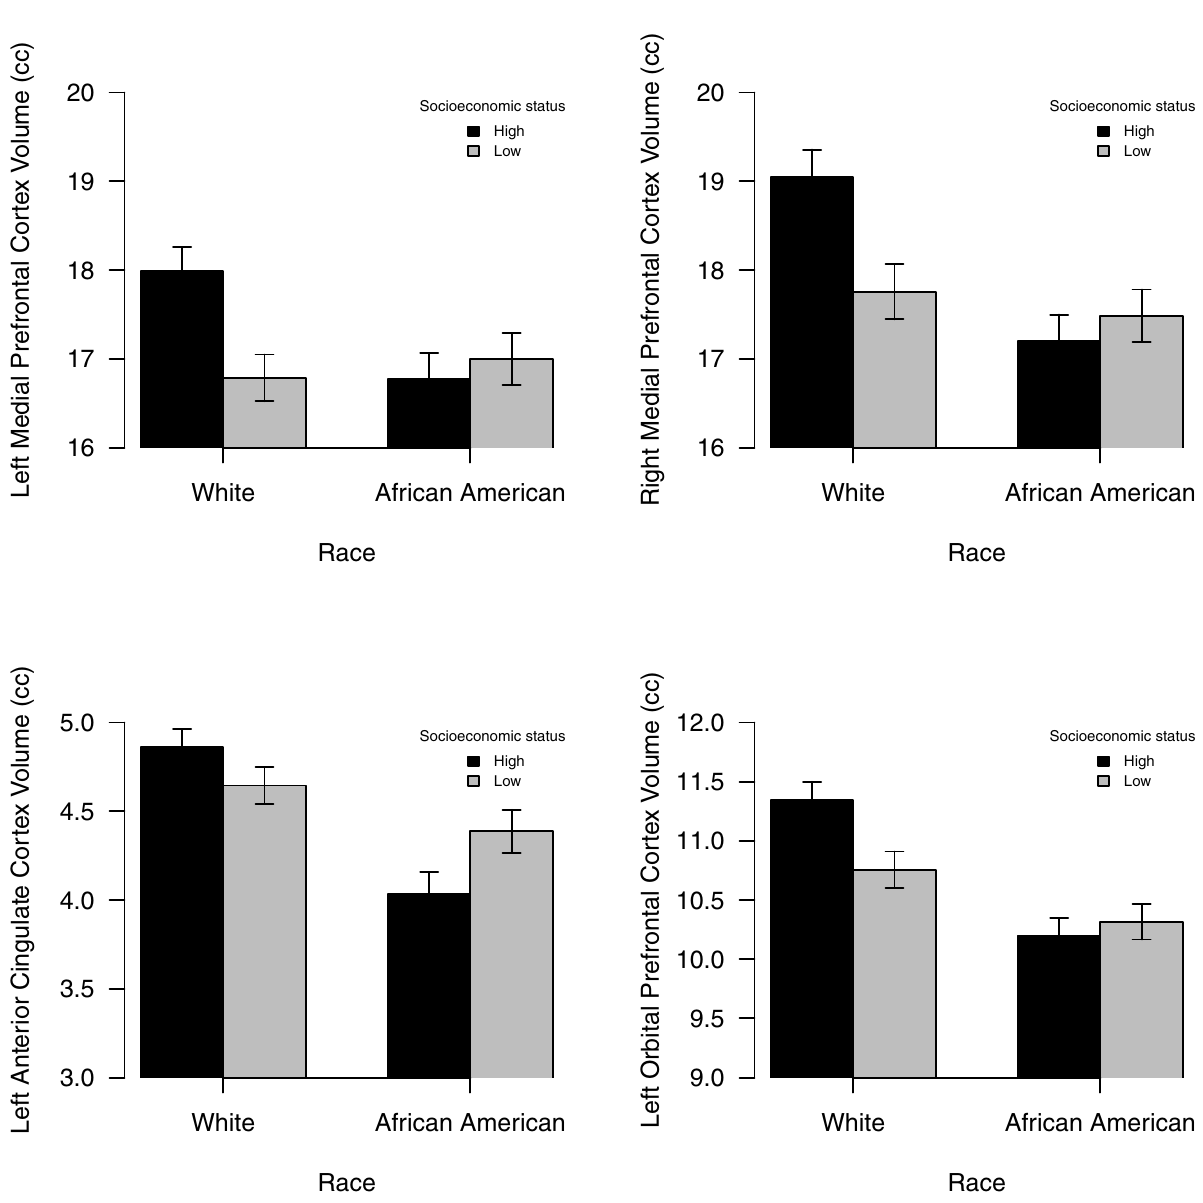
Fig 3. Graphical representation of significant SES by race interactions on various cortical brain regions. For all the structures depicted, high SES Whites had greater brain volumes relative to all other groups. Error bars depict the standard errors.